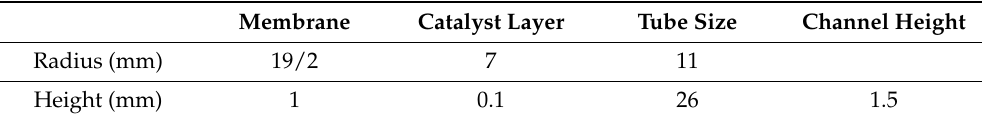
Figure 1. Concept of biogas converter using solid oxide cell. Geometric parameters of the various elements are listed in Table 1 (exact geometry is available in Supplementary Materials Figure S1). Table 1. Geometric